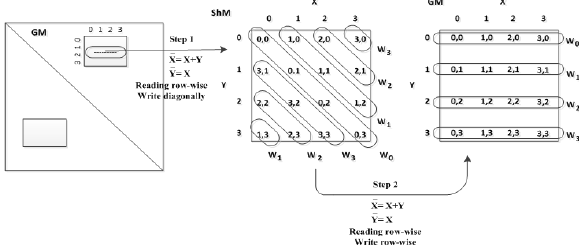
Figure 3: Threads and Elements mapping at each steps of the Second Algorithm (Parallel Write) The proposed approach to access elements